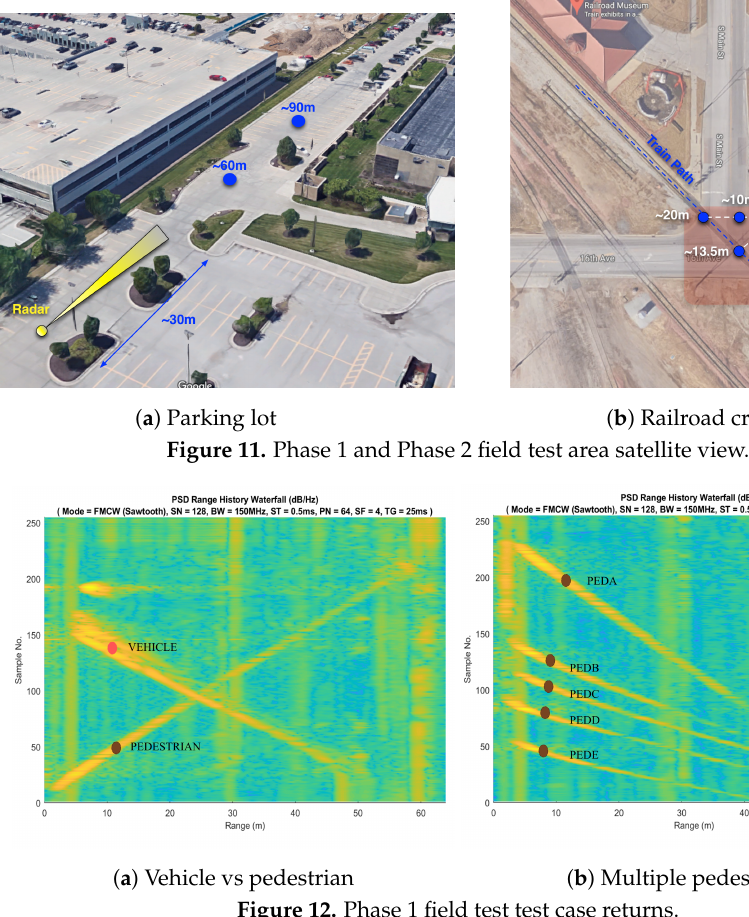
Figure 12. Phase 1 field test test case